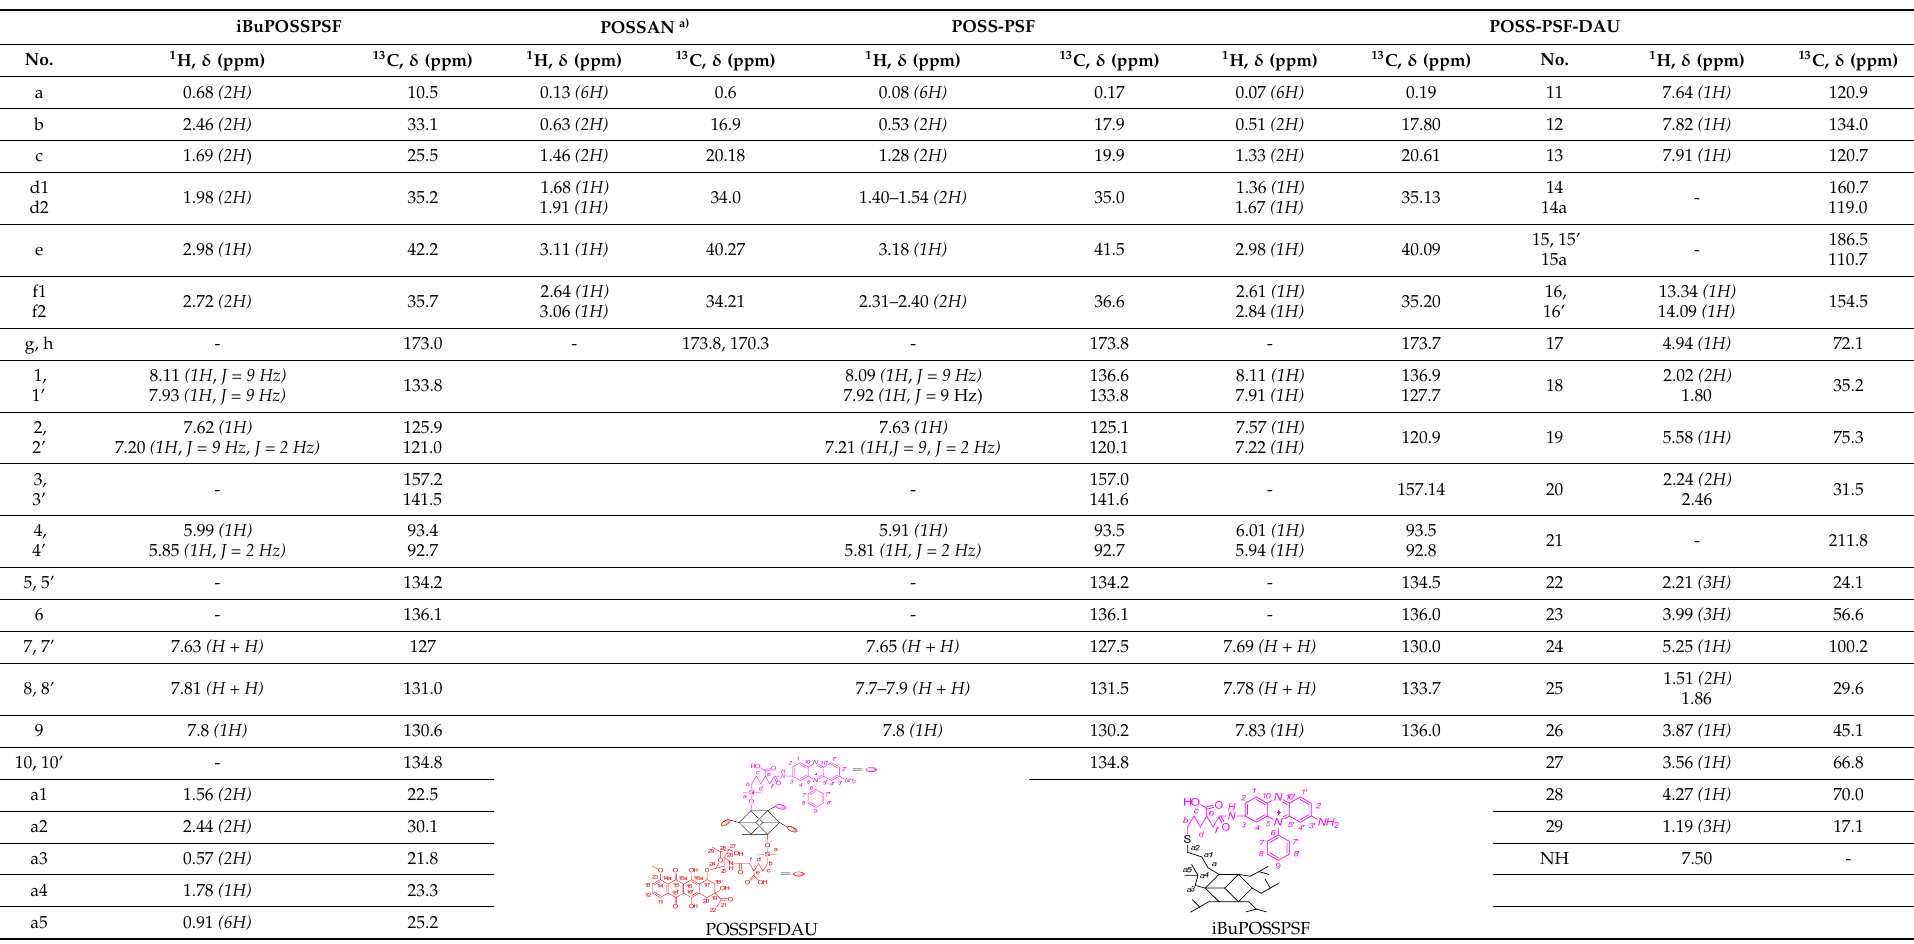
Table 1. 1 H, 13 C NMR shift assignment of PSF-photosensitizers in DMSO-d 6